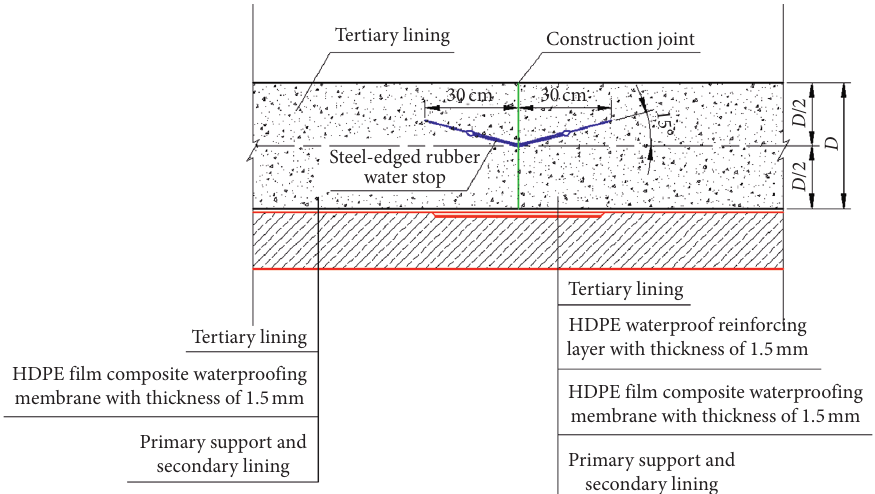
Figure 7: Schematic diagram of the waterproof structure of the circumferential construction